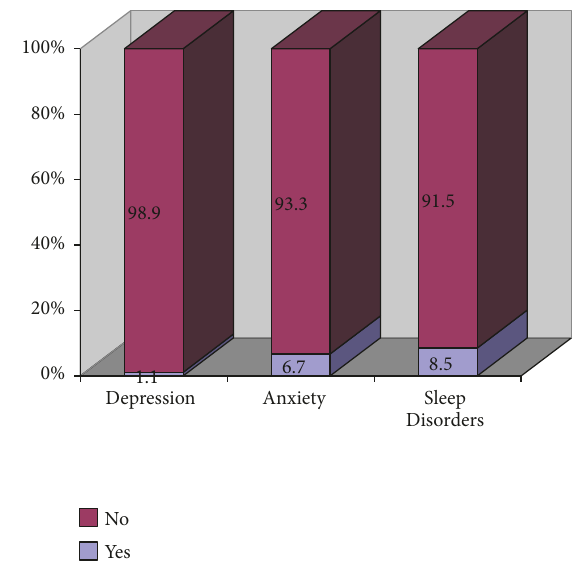
Figure 2: Medication history among emergency department physi- cians and nurses. Work-related characteristics of the